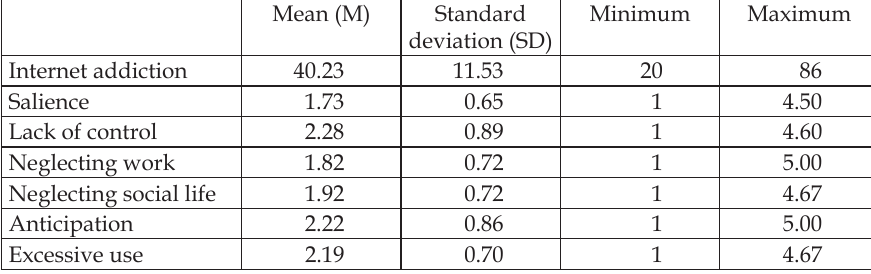
Table 1. Results from a descriptive analysis of the Internet Addiction Test Mean (M) Standard deviation (SD)